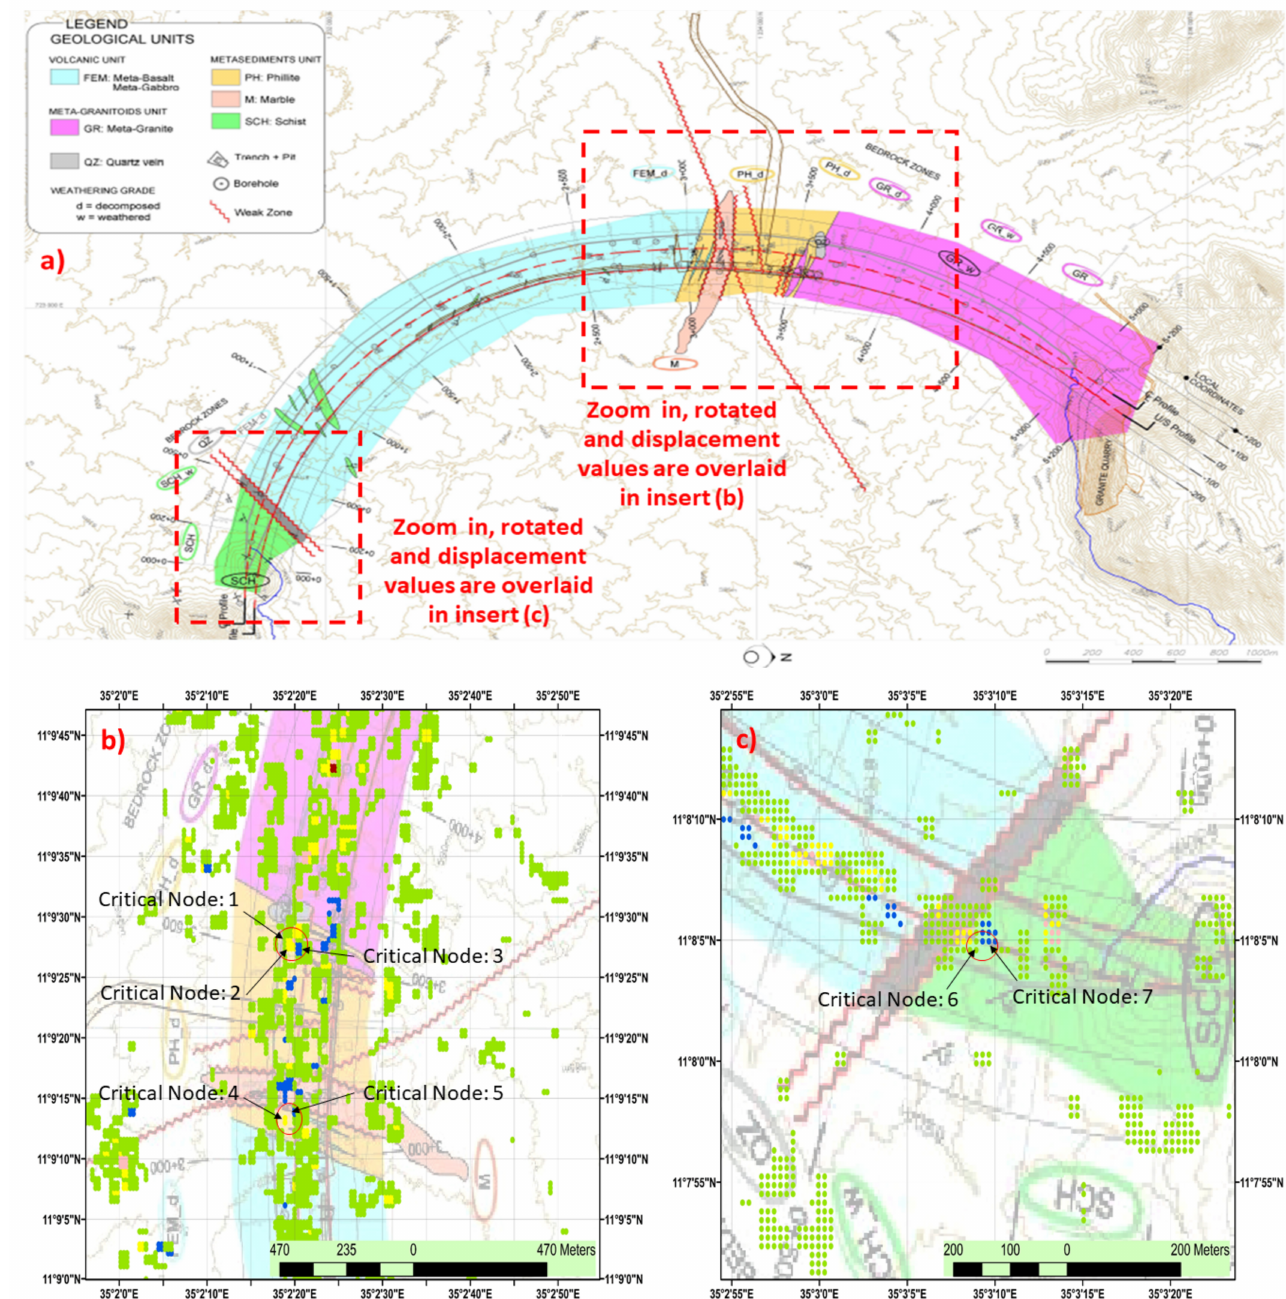
Figure 9. Saddle Dam general layout with ( a ) schematic geological plan of the Saddle Dam adopted from [46] with permission, ( b ) Identified critical nodes 1 to 5 within weak zone with associated vertical displacement overlaid from this current research between tunnels 1 and 2; and ( c ) Identified critical nodes 6 and 7 within weak zones with associated vertical displacement overlaid from this current research on the South